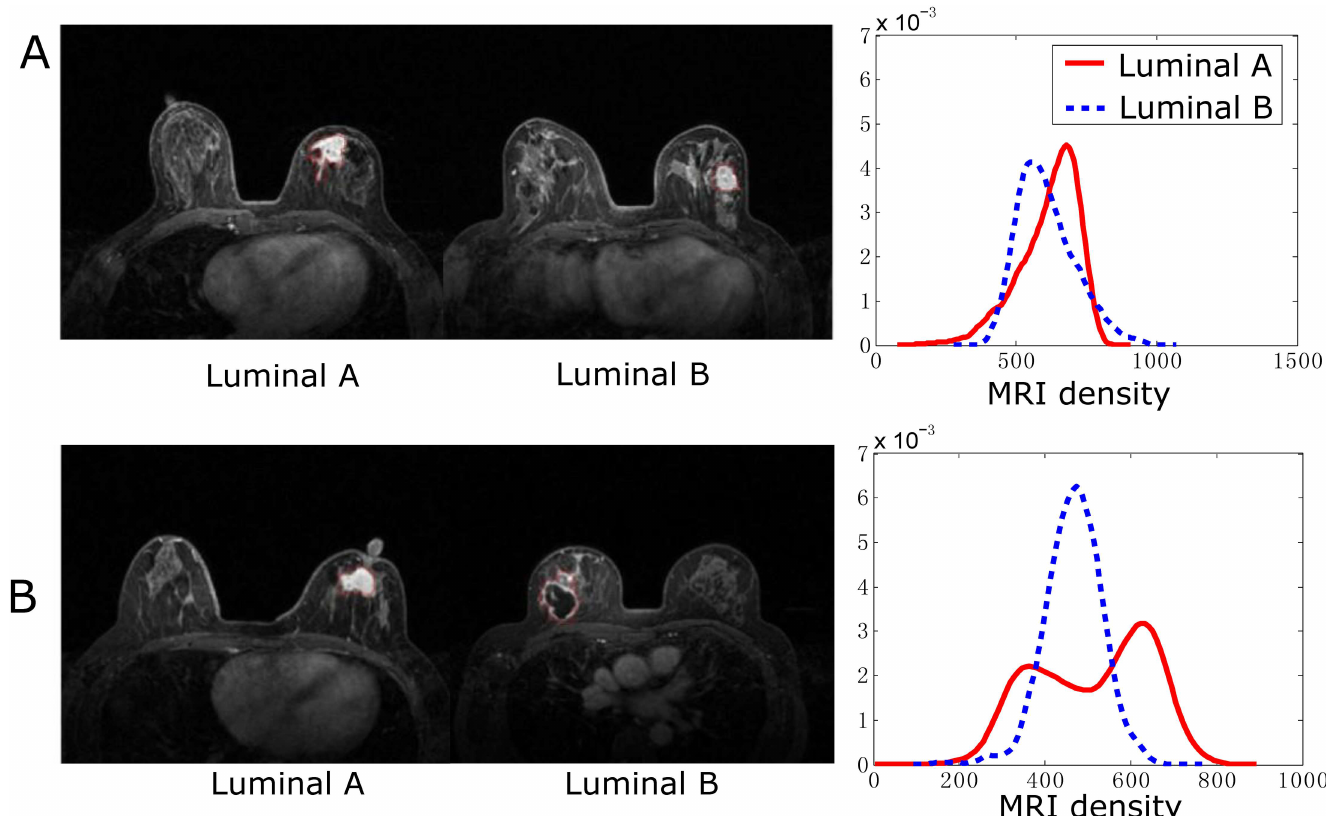
Fig 2. Representative imaging featuresdifferentiate tumors with different molecular subtypes. A) Postcontrast MRI of luminalA and luminalB breast cancers. B) Postcontrast MRI of luminalA and luminalB breast cancers and correspondingkurtosis density using a kernel